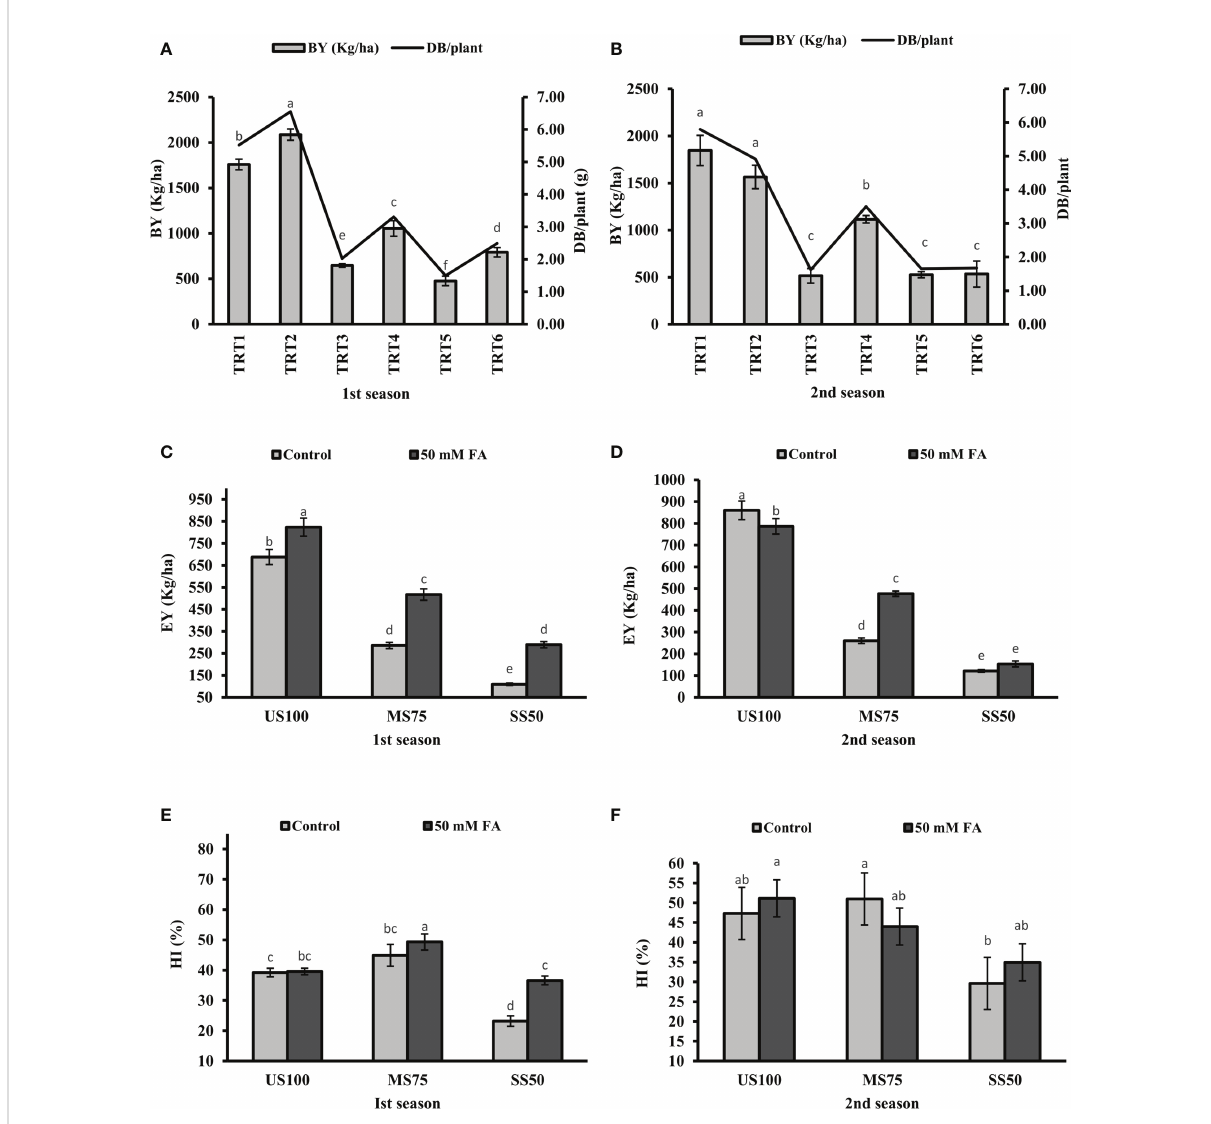
FIGURE 11 Effect of foliar application of folic acid (50 mM) on biological yield, economic yield, and harvest index in the fi rst (A, C, E) and second (B, D, F) seasons. The graph values are the mean ± SE of four replicates. The bars exhibited with different letters indicate a signi fi cant difference between samples by least signi fi cant difference ( p ≤